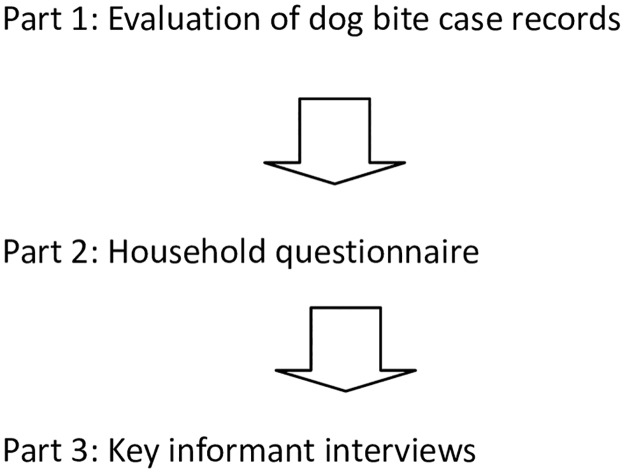
Parts of the study.